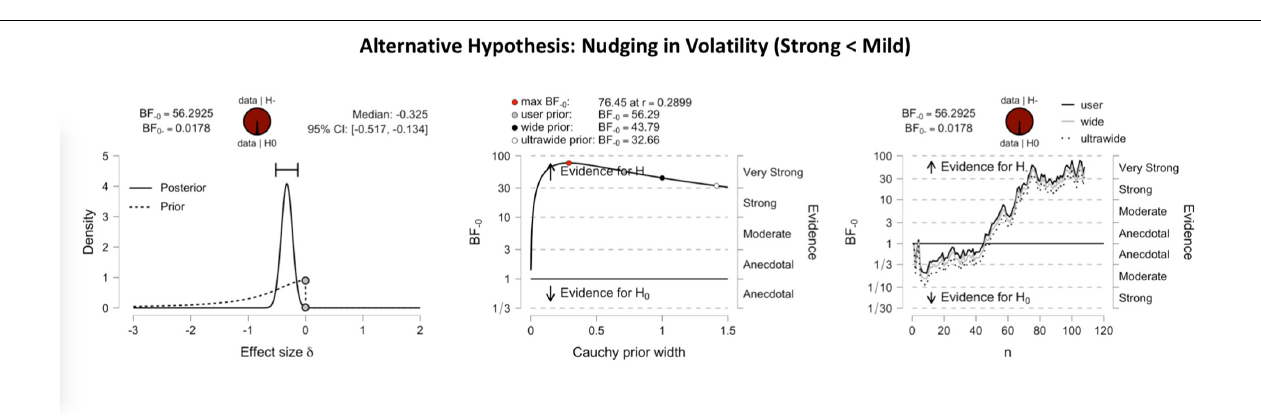
FIGURE 3 | Inferential plots of Bayesian paired-samples t -test, with predictive dissonance as the alternative hypothesis. The left panel shows the posterior and prior; the middle panel shows the Bayes factor robustness check, and the right panel shows the sequential analysis. With a Bayes factor BF 0 + of 41.08, the evidence appears very strong in favor of the null hypothesis as compared to the predictive dissonance hypothesis.